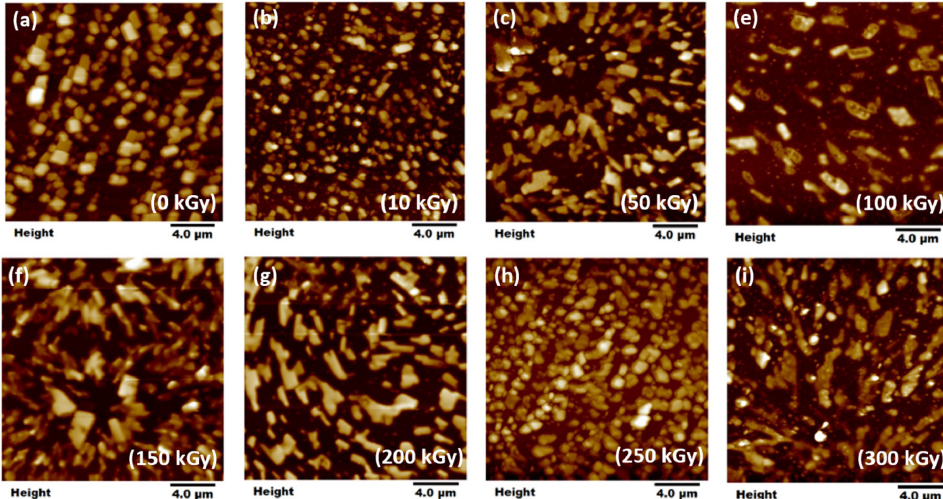
Figure 4. 2D AFM images of un-irradiated and gamma irradiated TIPS Pentacene thin